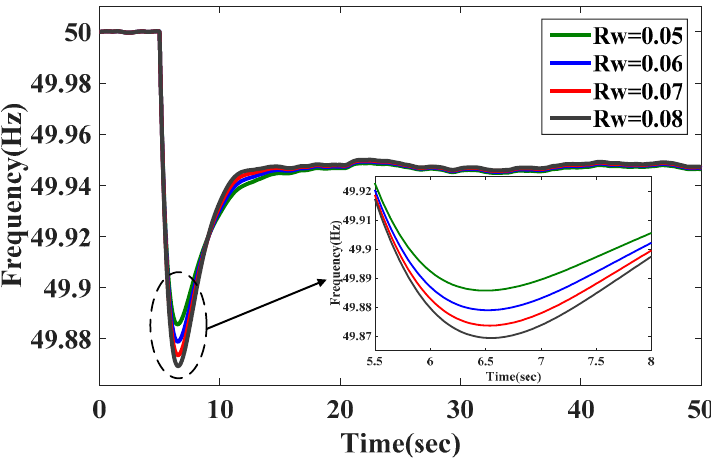
Figure 14. The impact of parameter R w on frequency dynamic response. Energies 2017 , 10 , 1797